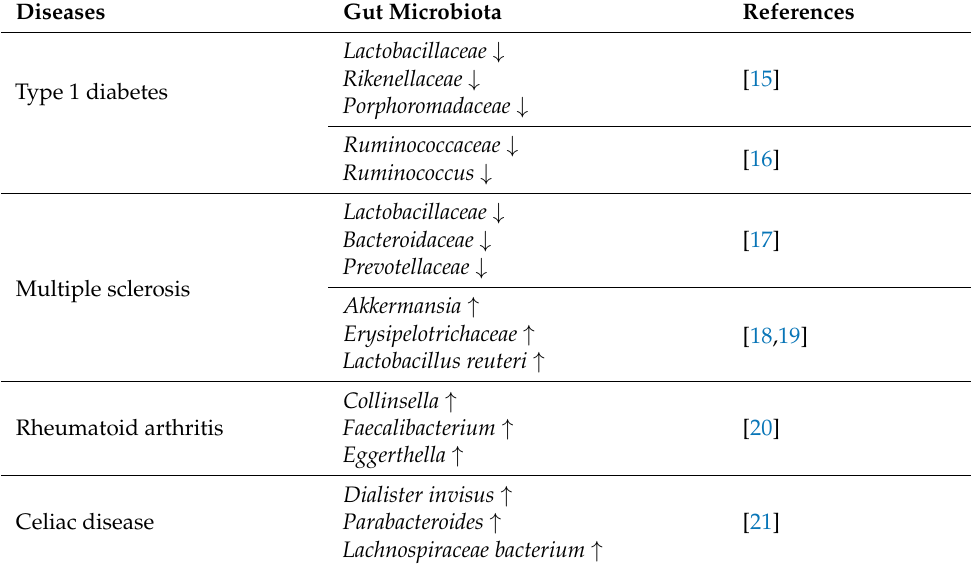
Table 1. Autoimmune diseases and gut